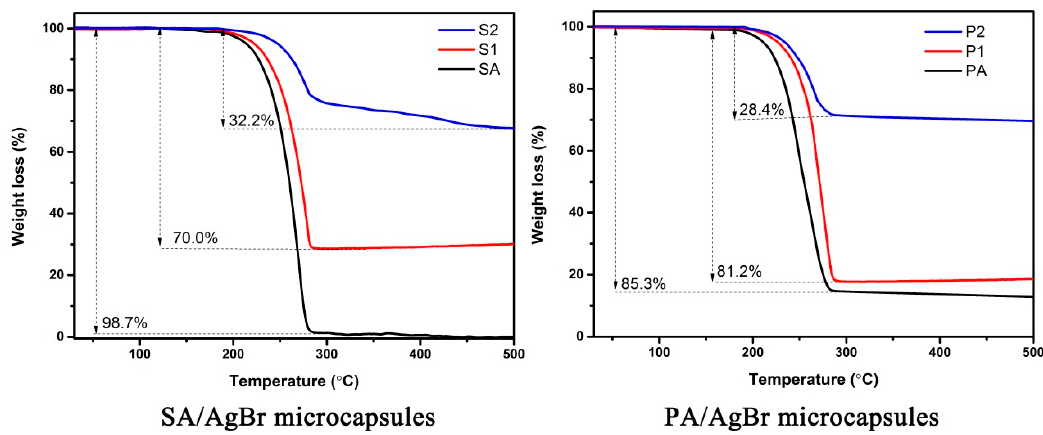
Figure 9. Define. curves for the SA/AgBr microcapsules and PA/AgBr microcapsules.